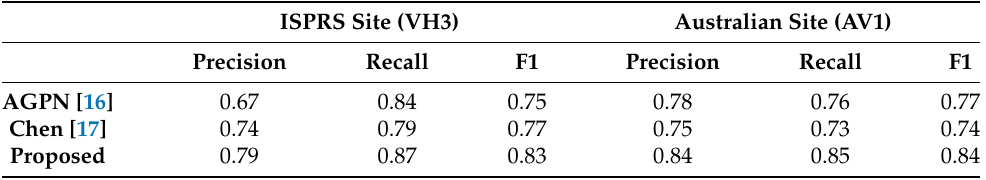
Table 4. Quantitative comparison of the extracted fold edge